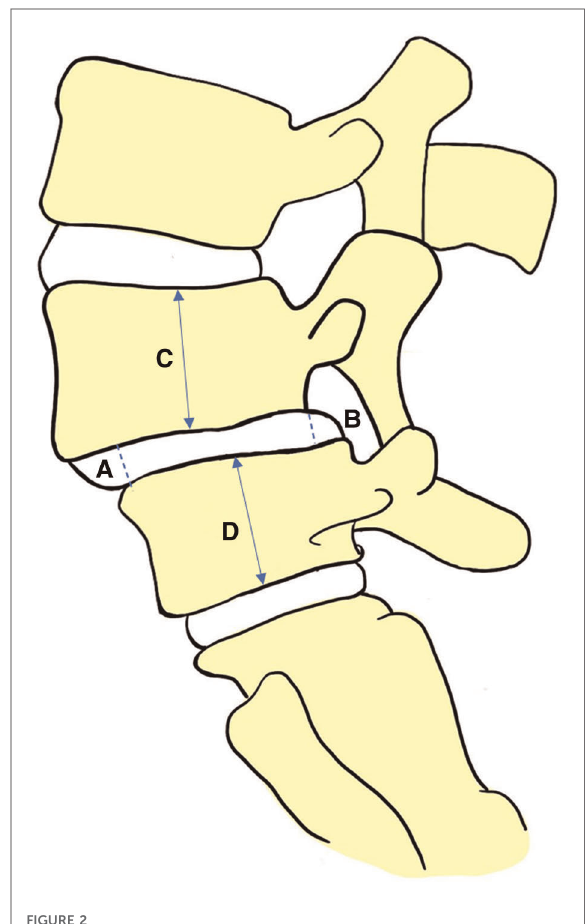
FIGURE 2 Measurement method of intervertebral disc height index: (A+B)/(C +D).